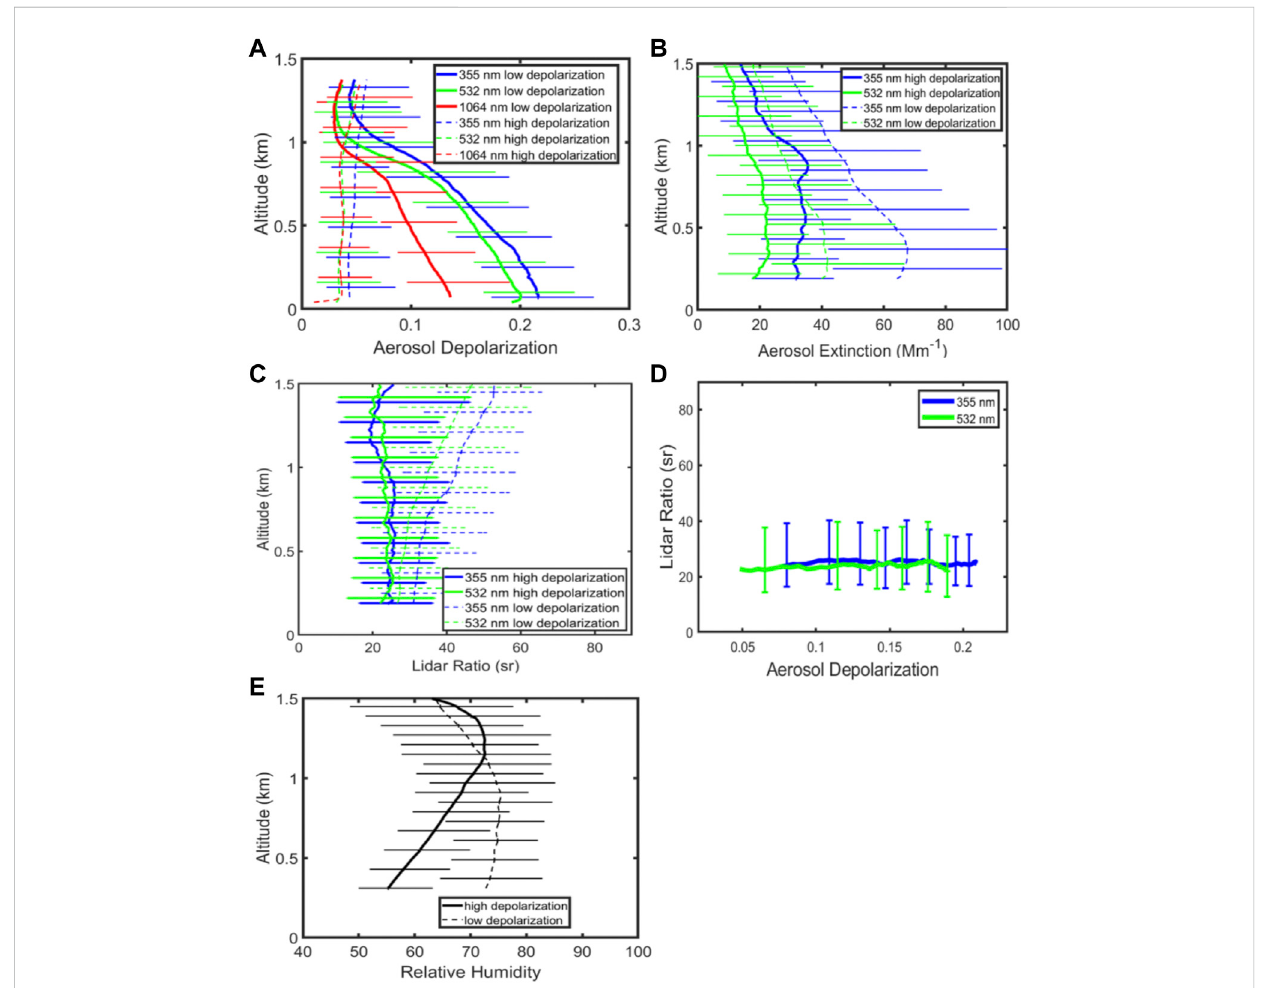
HSRL-2 pro fi les of (A) aerosol depolarization at 355, 532, and 1,064 nm, (B) aerosol extinction at 355 and 532 nm, and (C) lidar ratio at 355, and 532 nm for cases of low and high depolarization within the lowest 20% of the mixed layer using data from all fl ights. Low depolarization cases were chosen such that the median aerosol depolarization at 532 nm in the lowest 20% of the mixed layer was less than 0.15 for a given fl ight; high depolarization cases were chosen such that the median aerosol depolarization at 532 nm in the lowest 20% of the mixed layer was greater than 0.15 for a given fl ight. (D) Lidar ratio vs. aerosol depolarization throughout the mixed layer for the subset of high depolarization cases shown in a-c. (E) MERRA-2 pro fi les of RH for these same low and high depolarization